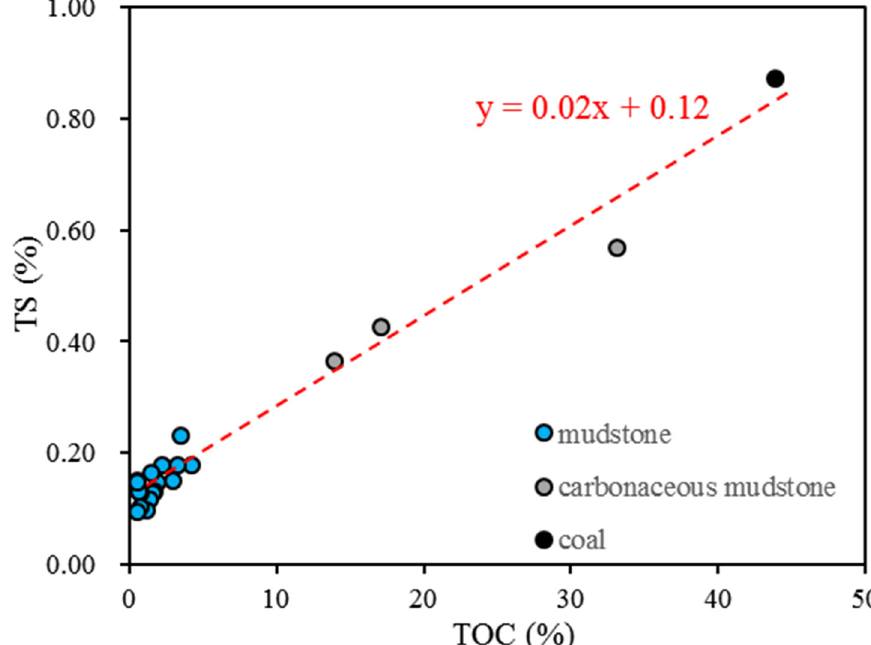
Figure 5. Relationship between TS and TOC for coal ‐ measure source rock.